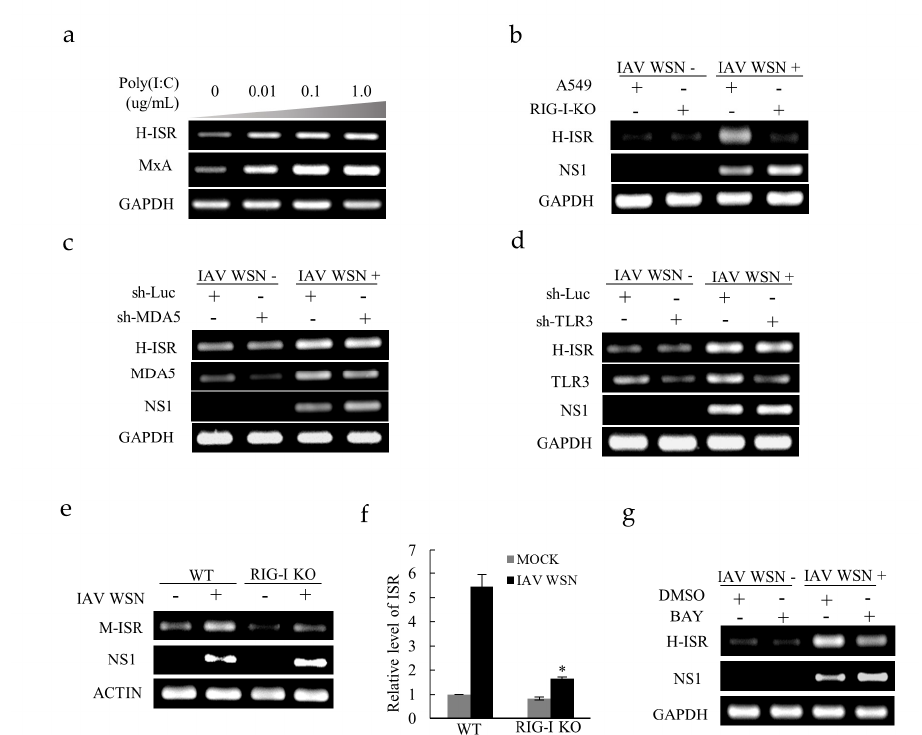
Figure 4. IAV-induced lncRNA ISR expression is regulated by RIG-I -dependent signaling. ( a ) A549 cells were treated with poly (I:C) at indicated concentrations for 4 h. RT-PCR was performed to determine lncRNA ISR expression; ( b ) A549 WT and A549 RIG-I -knockout (KO) cells were infected with or without IAV WSN (MOI = 0.8). At 16 hpi, total RNA was extracted for RT-PCR to detect lncRNA ISR expression; ( c ) The expression levels of lncRNA ISR in MDA5 knockdown and sh-Luc control cells infected with or without IAV WSN (MOI = 0.8) were determined by RT-PCR; ( d ) The expression levels of lncRNA ISR in TLR3 knockdown and sh-Luc control cells infected with or without IAV WSN (MOI = 0.8) were determined by RT-PCR; ( e , f ) C57BL / 6 WT and RIG-I -KO mice were infected intranasally with or without 5 × 10 4 pfu of IAV WSN virus ( n = 8 mice / group). At 24 hpi, the lungs were collected and subjected to RT-PCR ( e ) and qRT-PCR ( f ) to detect lncRNA ISR expression. Data are represented as mean ± S.D. * p < 0.05; ( g ) A549 cells were treated with 8 µ M NF- κ B inhibitor BAY 11-7082 (BAY), followed by infection with / without IAV WSN (MOI = 0.8). At 16 hpi, total RNA was analyzed by RT-PCR to determine lncRNA ISR expression.